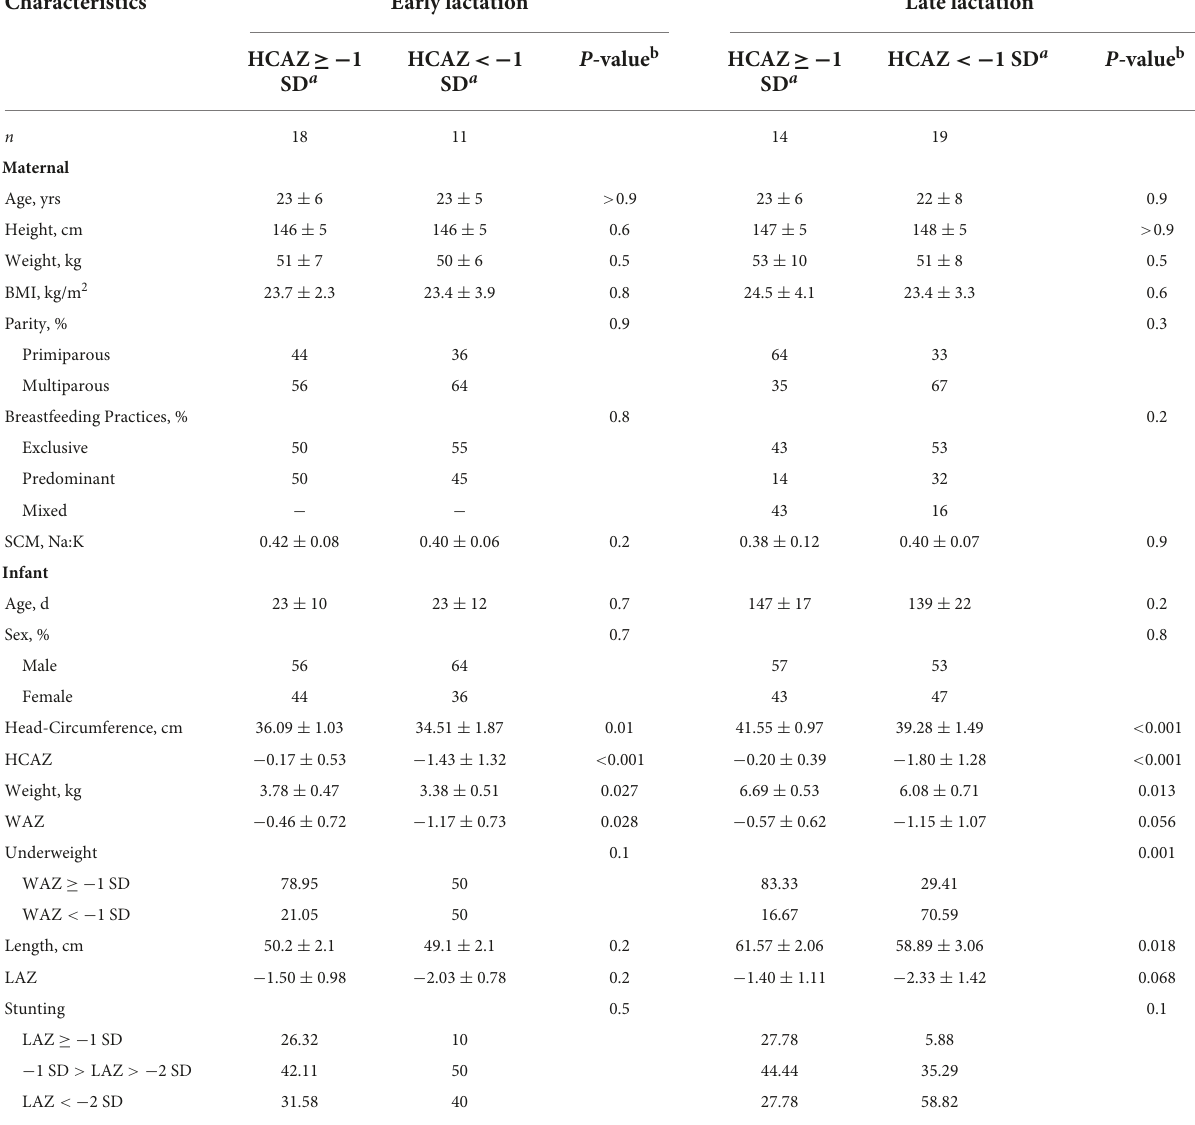
TABLE 1 Population characteristics of mothers and infants at 2 stages of lactation (¯x ± SD or %).